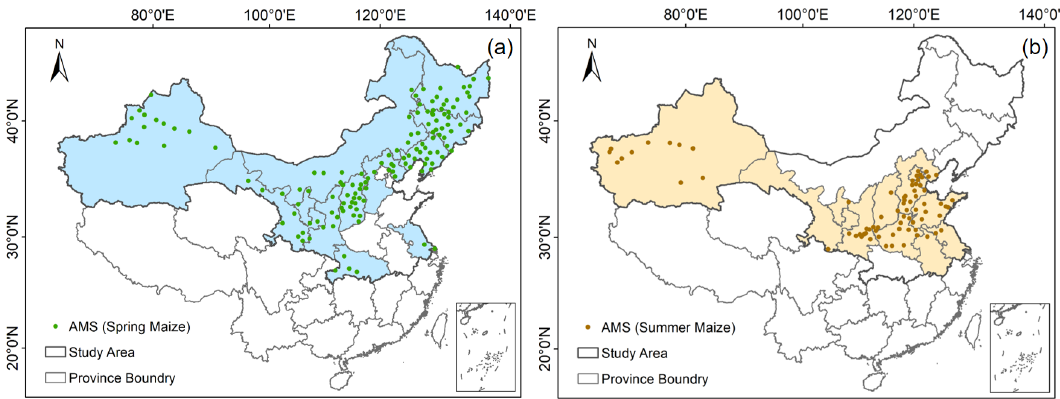
Figure 2. Distribution of agricultural meteorological stations (AMS) with phenology records of spring (a) and summer (b) maize. The blue and yellow areas are provinces with available AMS in this study.